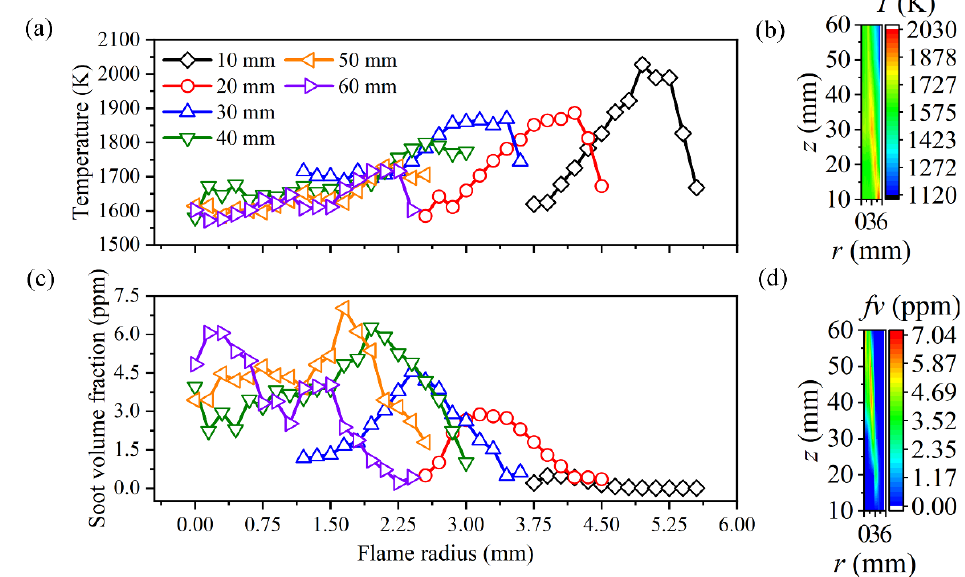
Figure 2. The exact data of temperature and soot volume fraction [45]. ( a ) The main cross-section flame temperature in the sooting regions; ( b ) The 2D distribution of flame temperature; ( c ) The main cross-section soot volume fraction in the sooting regions; ( d ) The 2D distribution of soot volume fraction.